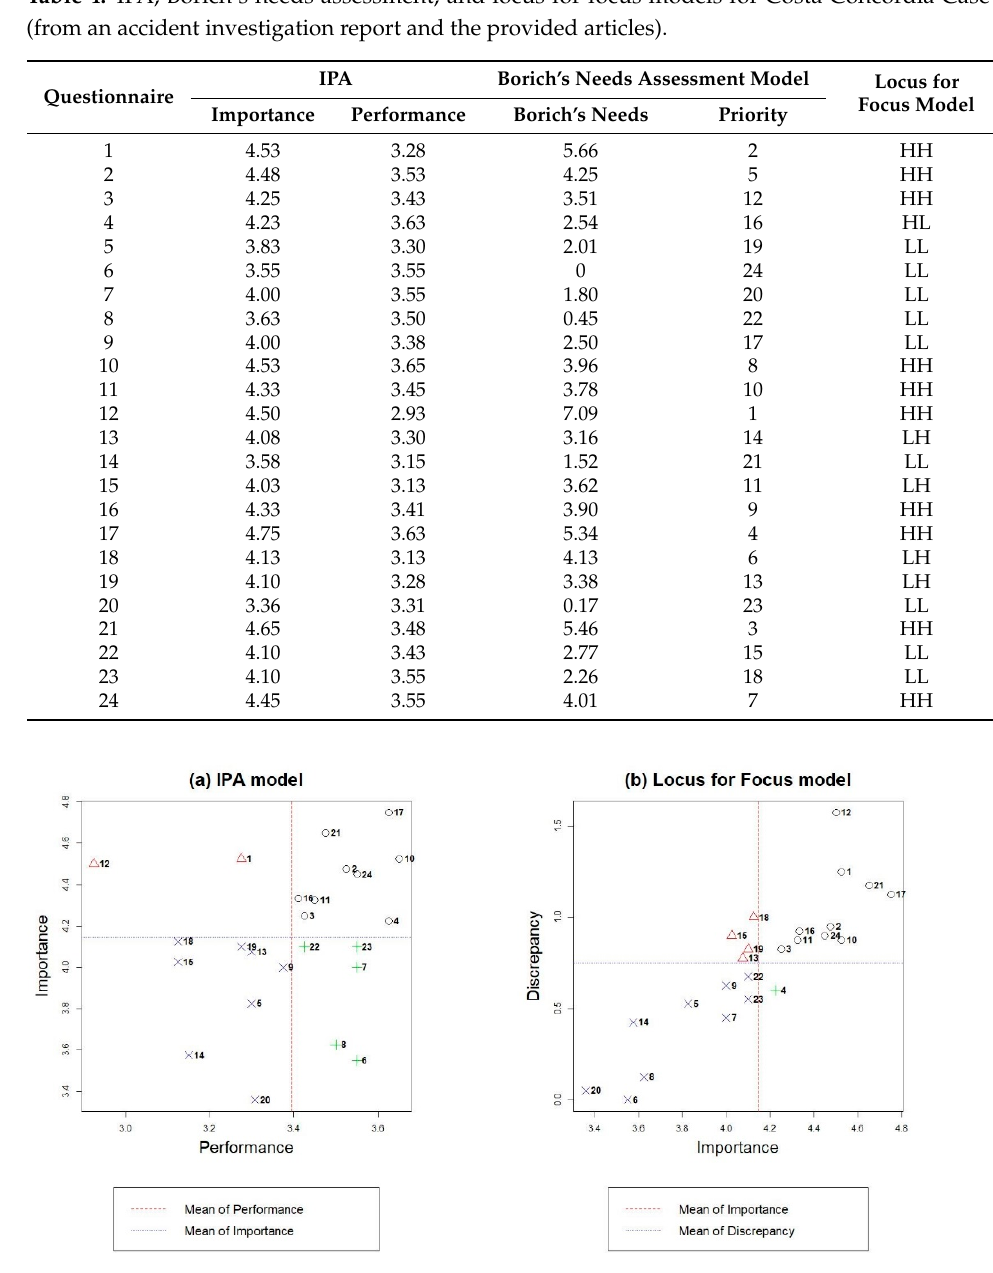
Figure 3. Analysis of the causes of the Costa Concordia accident from the provided articles using: ( a ) IPA model; ( b ) locus for focus model.